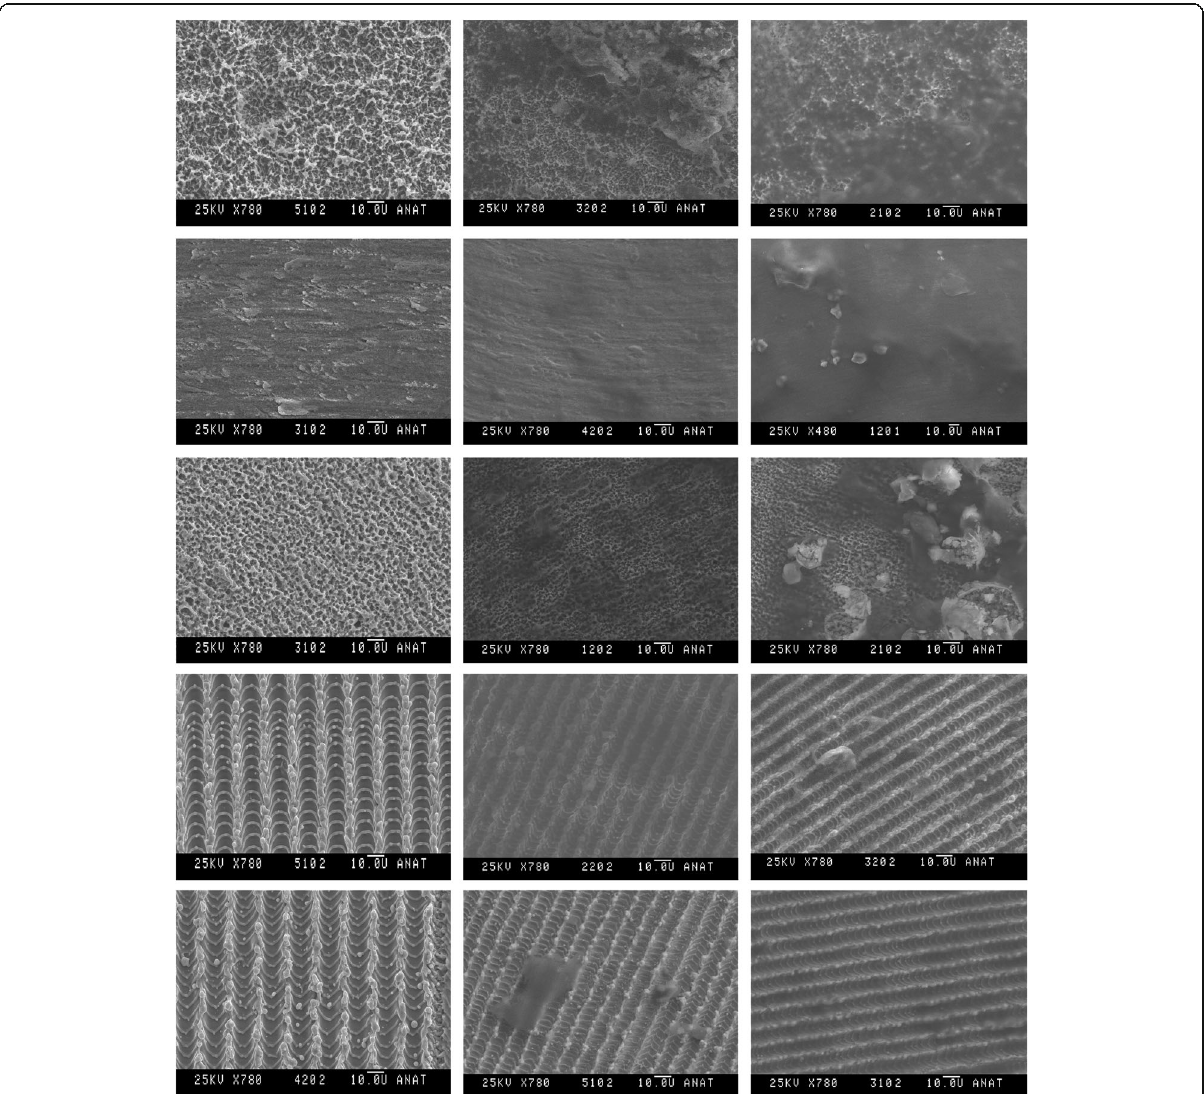
Fig. 3 Images of scanning electron microscopy, showing different native samples on the left side, samples after 24 h and 48 h biofilm collection regarding the groups. spCPTi, smooth pickled titanium; sehCPTi, hydrophilic smooth and acid-etched titanium; CPTi Promote, titanium Promote; LL CPTi, Laser-Lok titanium; LL TAV, Laser-Lok titanium aluminium